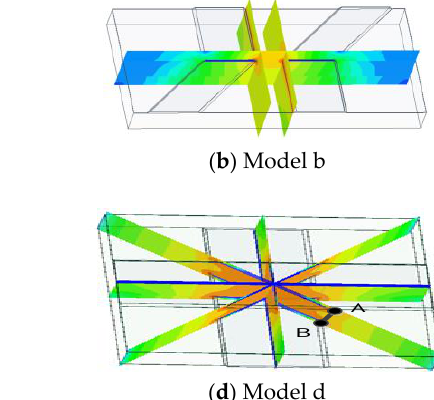
Figure 3. Electric field simulation distribution of the four models.